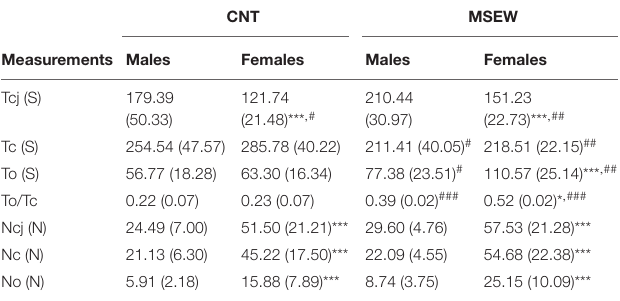
TABLE 3 | Performance of adult rats on the elevated-plus maze